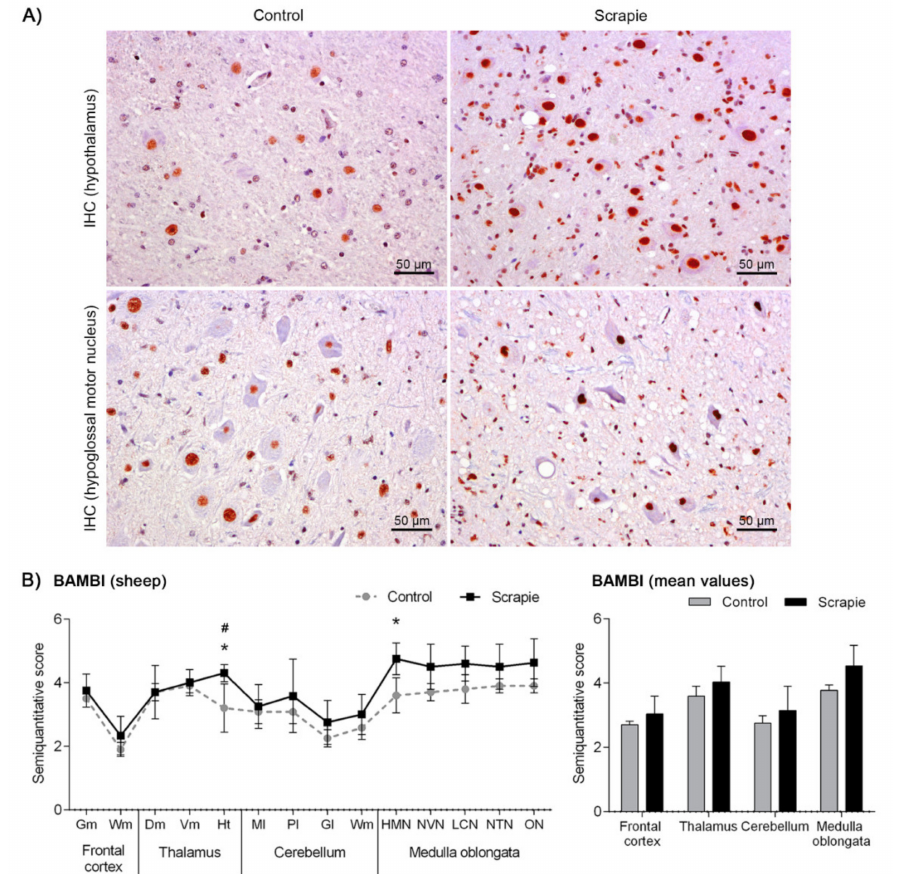
Figure 2. Immunostaining patterns and semi-quantitative scoring of BAMBI in the central nervous system of scrapie-infected sheep. ( A ) Representative images of BAMBI immunostaining in the hypothalamus and hypoglossal motor nucleus (50 µ m). This protein displayed a homogeneous intranuclear pattern in both neurons and glial cells in scrapie and control sheep, although the amount of immunopositive cells and the intensity of immunolabelling were moderately larger in some regions of the clinical sheep. ( B ) Comparative graphs between scrapie (black bars) and control sheep (grey bars). Score values (from 0: negative, to 5: staining present at its maximum intensity) evaluated in the frontal cortex, thalamus, cerebellum and medulla oblongata. Abbreviations: grey matter (Gm), white matter (Wm), dorsomedial (Dm), ventromedial (Vm), hypothalamus (Ht), molecular layer (Ml), Purkinje layer (Pl), granular layer (Gl), hypoglossal motor nucleus (HMN), dorsal nucleus of the vagus nerve (NVN), lateral cuneate nucleus (LCN), nucleus of the trigeminal nerve spinal tract (NTN), olivary nucleus (ON). Significant di ff erences were determined using the Mann Whitney U test (* p < 0.05). Significant di ff erences after Bonferroni correction for multiple tests are shown as # p <